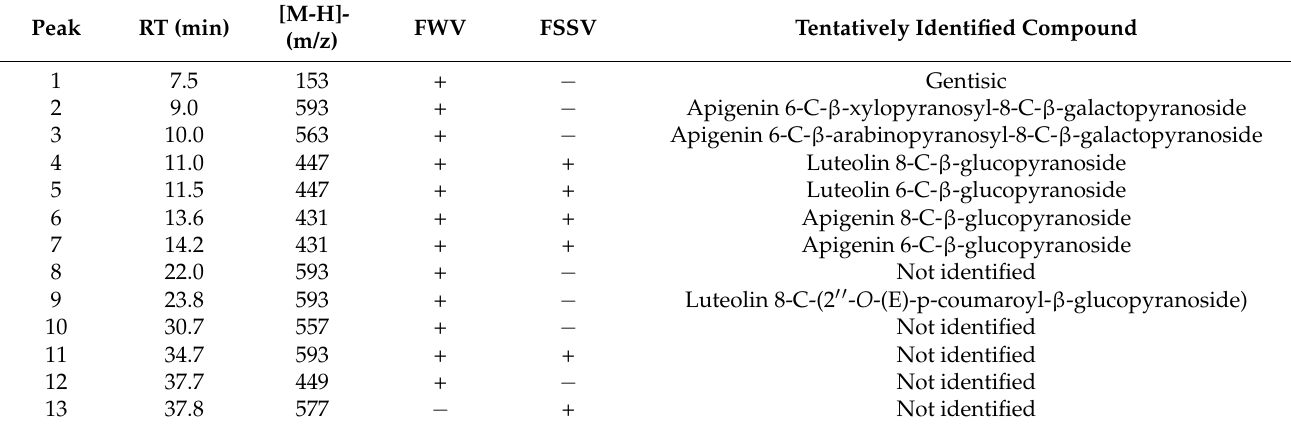
Table 5. Phenolic compounds analyzed by HPLC-ESI-MS in purified ethanol extracts of FWV and FSV